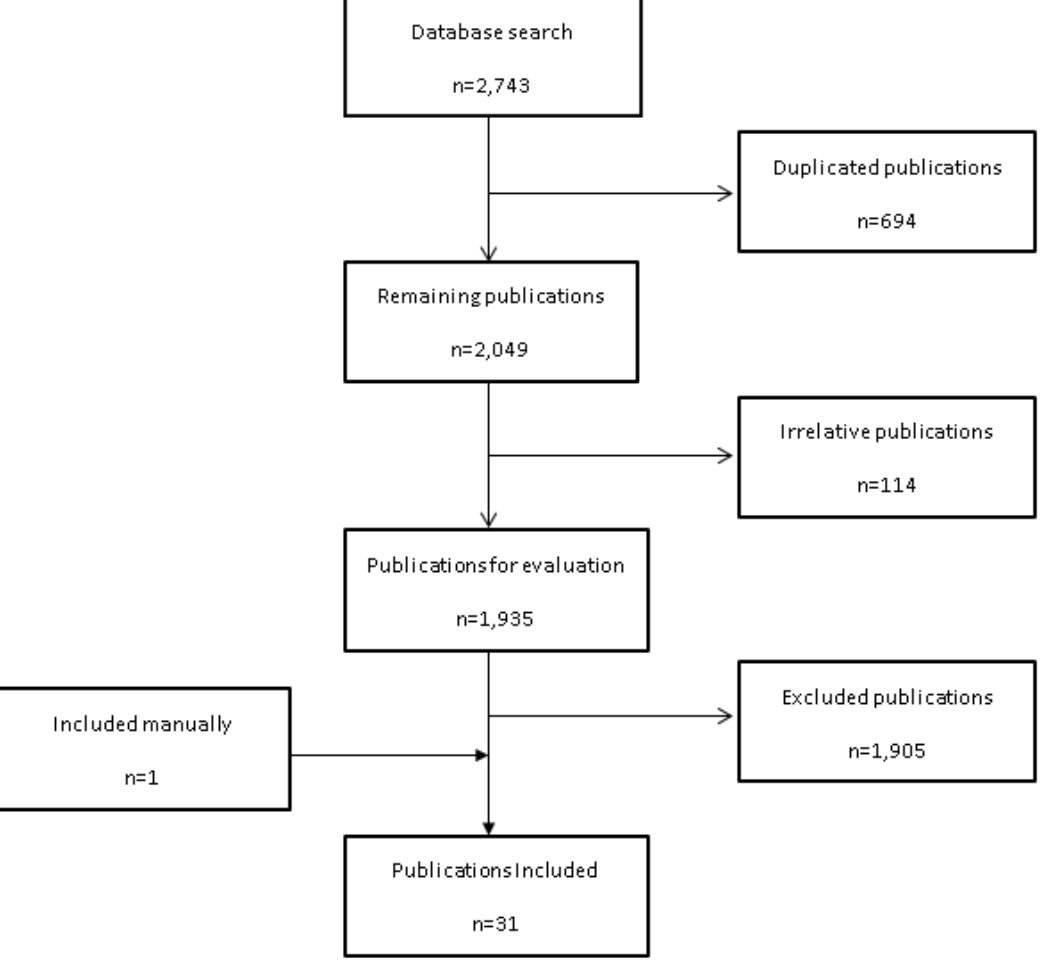
Figure 1. Flow chart for study retrieval and selection.